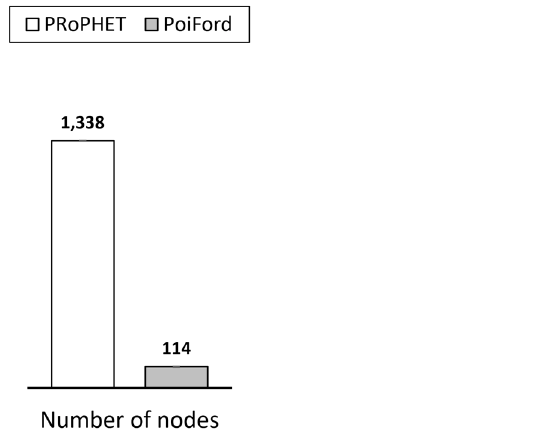
Figure 6. The average number of nodes for which encounter history is maintained.